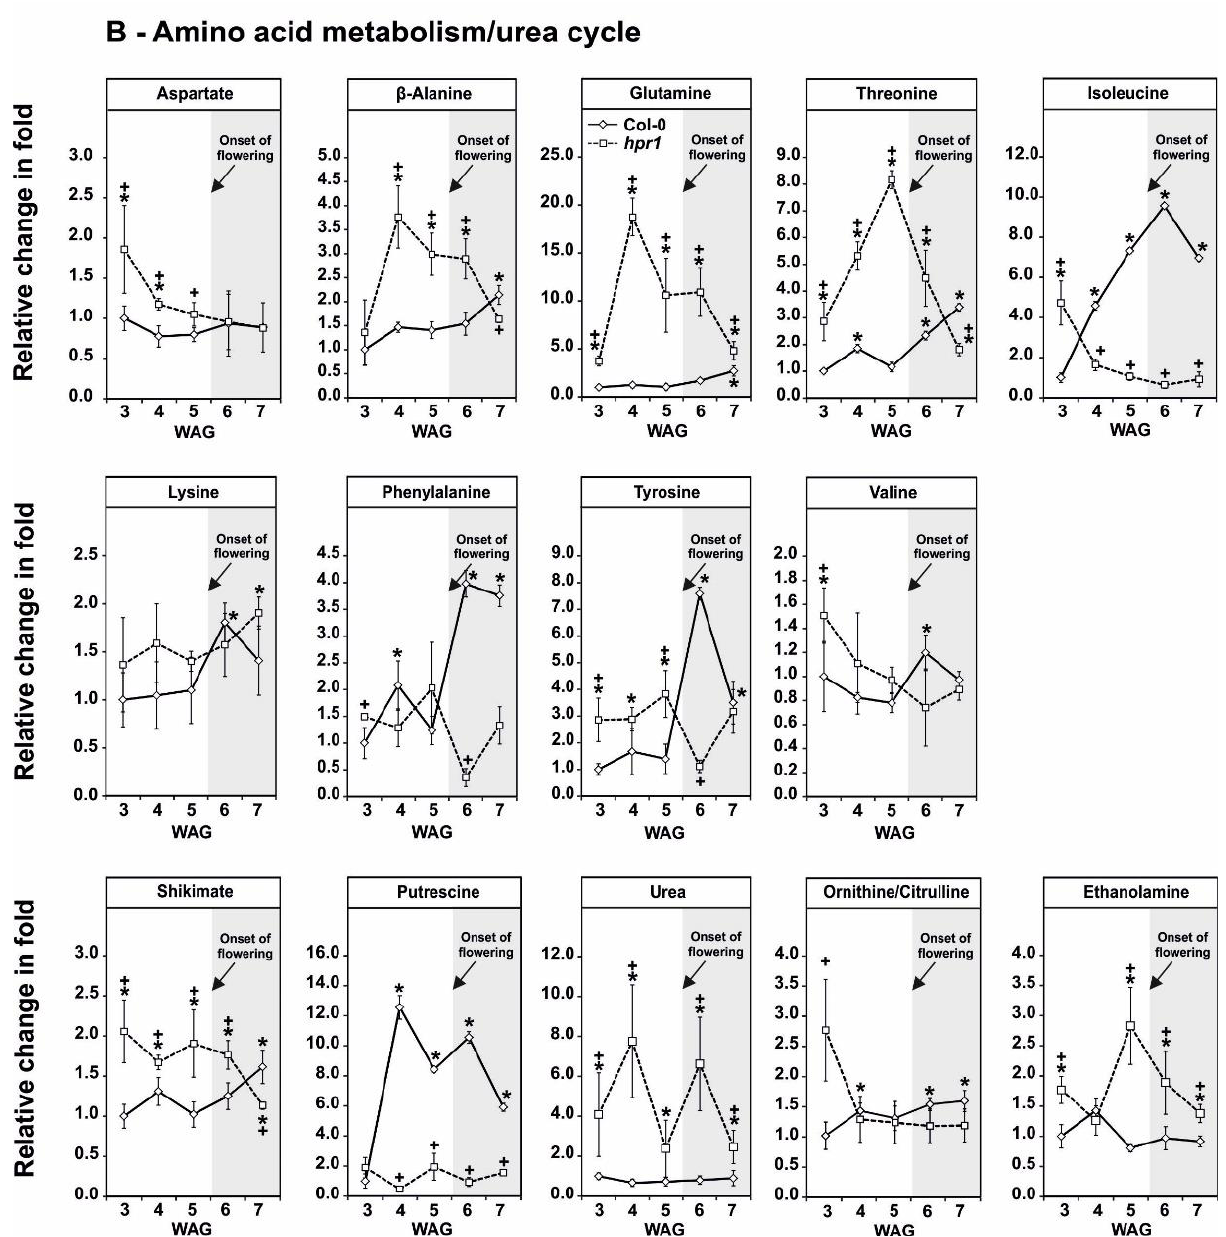
Figure 5. Metabolic acclimation patterns of the TCA cycle and amino acid metabolism during development. Metabolite abundances of selected intermediates of ( A ) the TCA-cycle and ( B ) amino acid metabolism and the urea cycle in Arabidopsis wild-type and hpr1 mutant plants during development (3–7 weeks after germination [WAG]). Plants were grown under controlled environmental conditions (390 ppm CO 2 , ~120 µmol m −2 s −1 light intensity, 20/18°C day/night temperature, ~70% relative humidity) in a balanced photoperiod (12/12 h day/night cycle). Mutant-to-wild-type ratios ± SD (five biological replicates) are shown (relative amounts, arbitrary units mg −1 fresh weight), with the mean wild-type value at 3 WAG arbitrarily set to 1 (wild type, solid line; hpr1 , dashed line). The white shaded part of the graph represents the vegetative phase, while grey shading the reproductive phase. Asterisks show significant changes compared with the wild-type time point, and plus signs (* p < 0.05) show them compared with the wild type at 3 WAG according to Student’s t -test (* p <